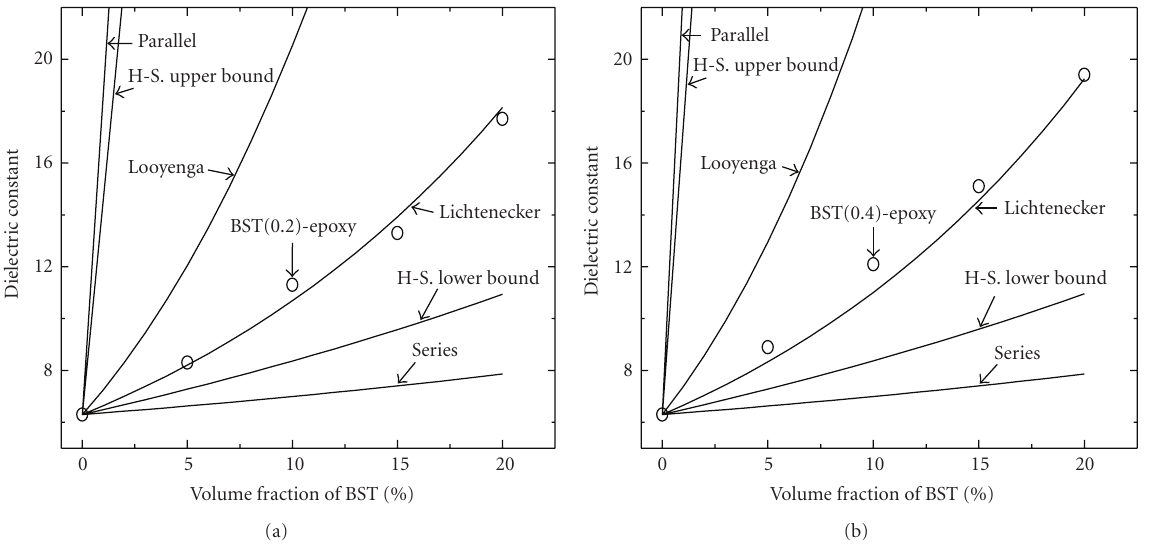
Figure 7: Theoretical mixture models and experimental result for BST-epoxy as function of volume fraction at 10 KHz.